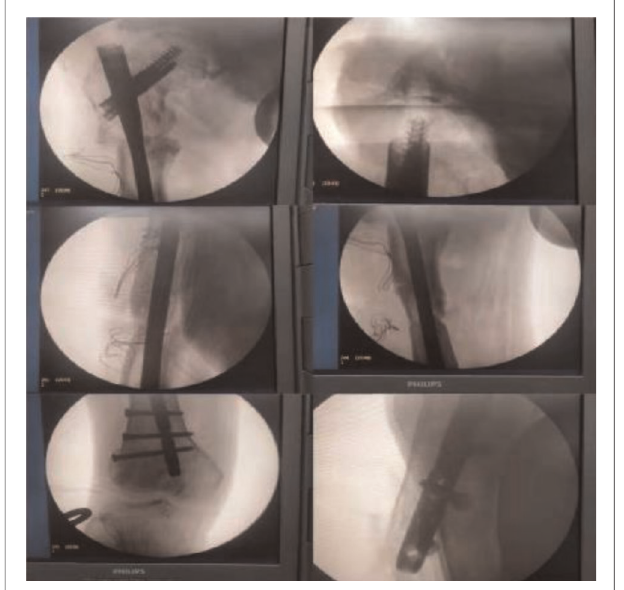
FIGURE 5 | Intraoperative fl uoroscopic imaging.